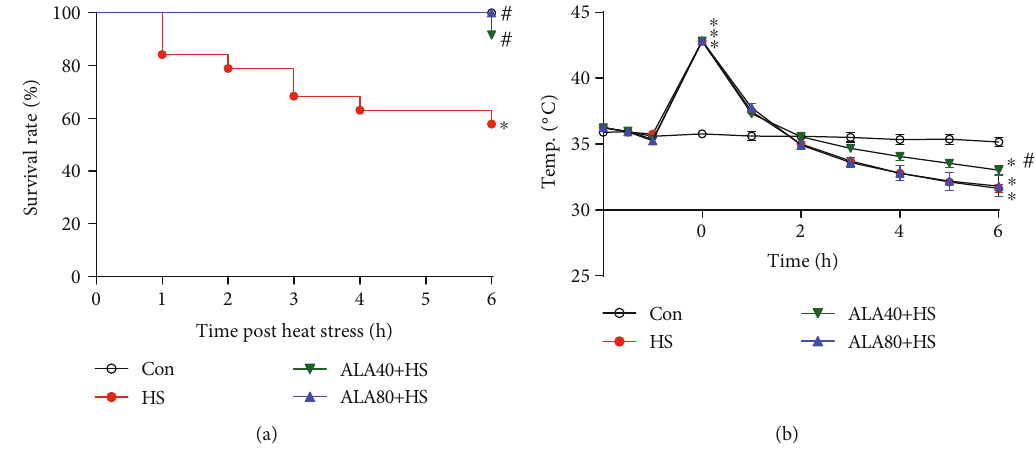
Figure 2: E ff ects of pretreatment with α -lipoic acid (ALA) on (a) survival rate and (b) core temperature in heat stroke rats. Data are expressed as mean ± SEM . ∗ P < 0 : 05 versus Con; # P < 0 : 05 versus